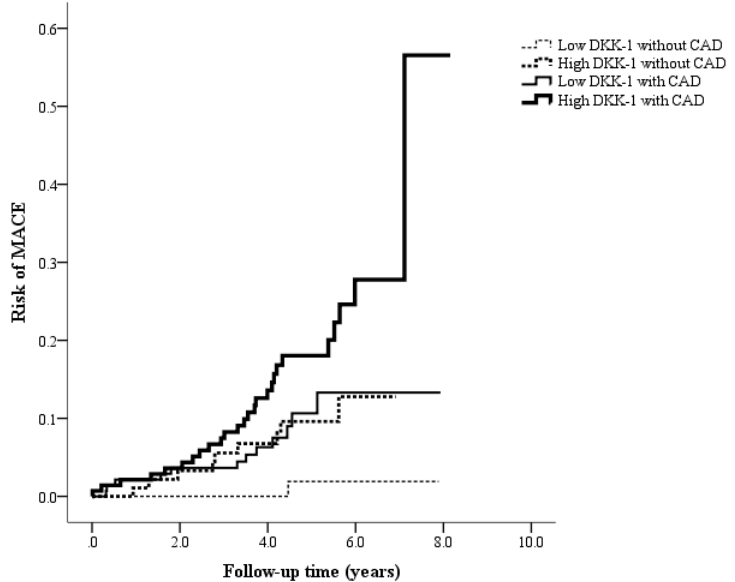
Figure 3. Kaplan–Meier curves showing the risk of major adverse cardiac events (MACEs) across the four groups, categorized using the median dickkopf-1 (DKK-1) value of 610 pg/mL and coronary artery disease (CAD) status (log-rank test: p = 0.001).